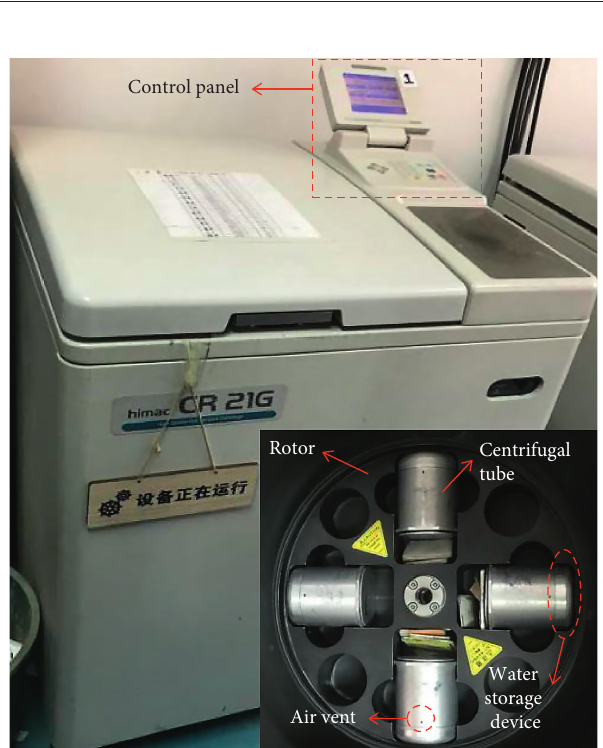
Figure 2: High-speed thermostatic refrigerated